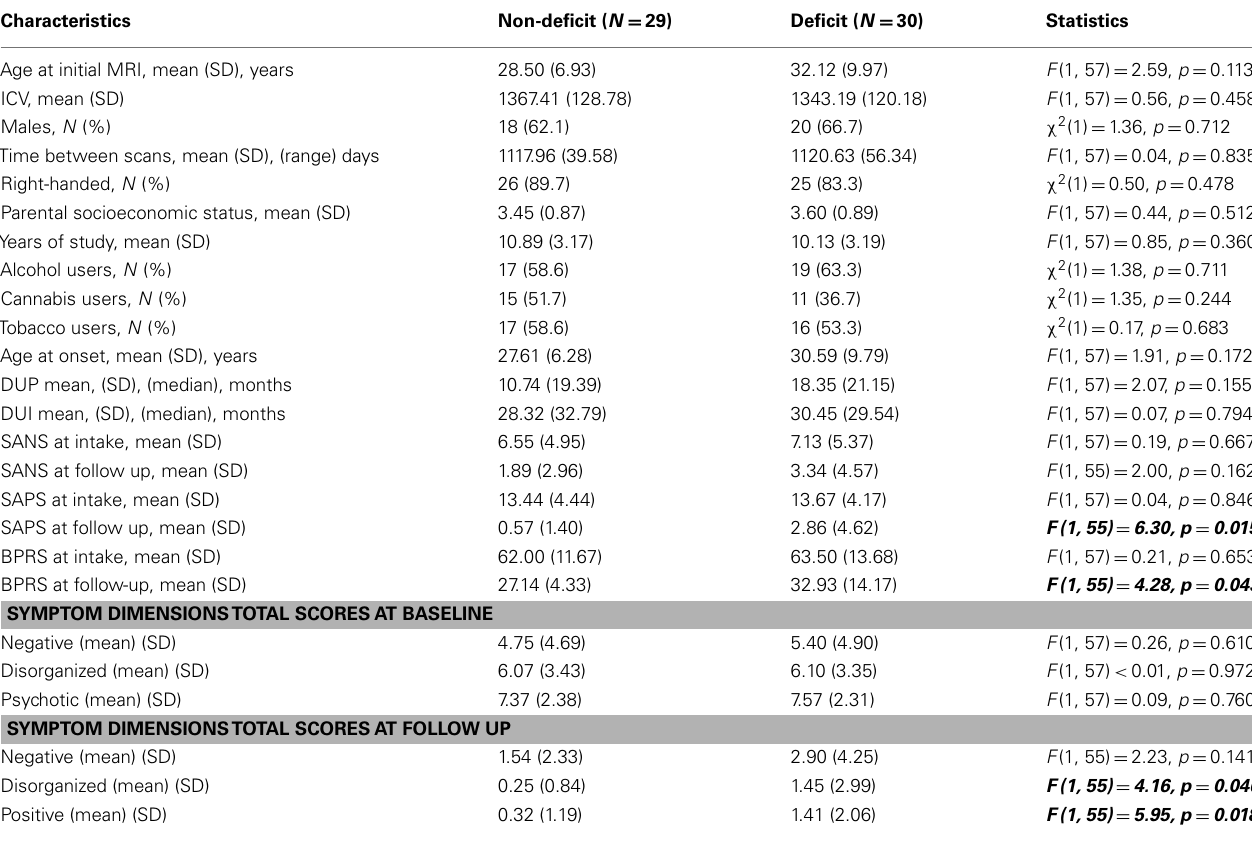
Table 1 | Sociodemographic and clinical characteristics of the two neurocognitive groups of patients.